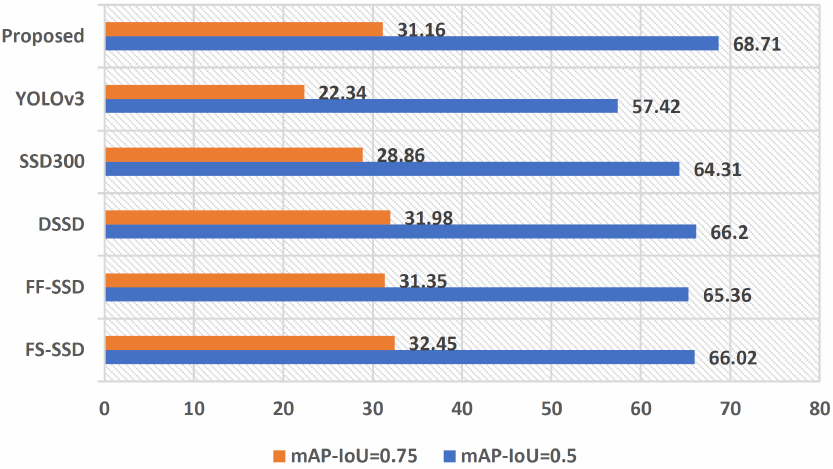
Figure 16. Comparison of mAP with IoU of 0.5 and 0.75 on the Pedestrian category of the SDD